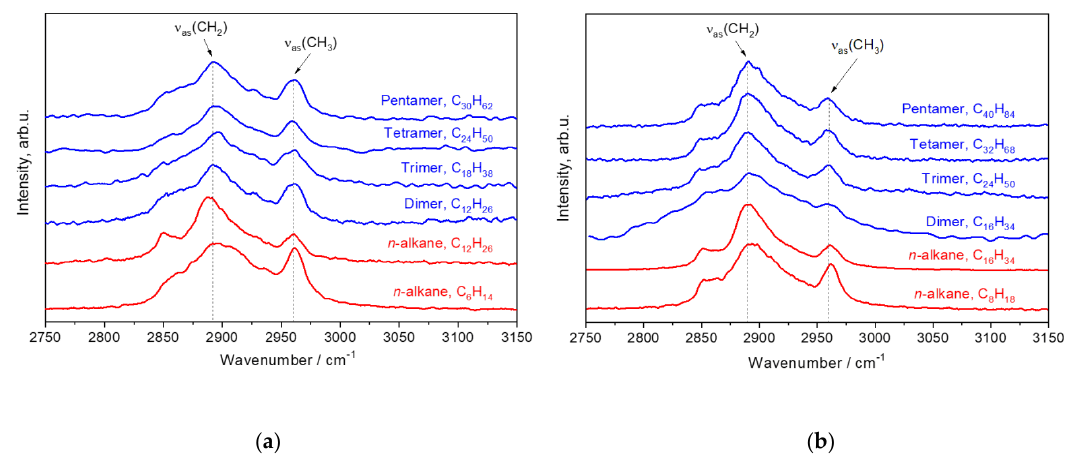
Figure 11. Polarized Raman spectra of the hydrogenated 1-hexene ( a ) and 1-octene ( b ) oligomers and linear alkanes C 6 H 14 , C 8 H 18 , C 12 H 26 , and C 16 H 34 in the region 2750–3150 cm − 1 . These spectra are recorded at the crossed orientation of the exciting and scattered radiation.